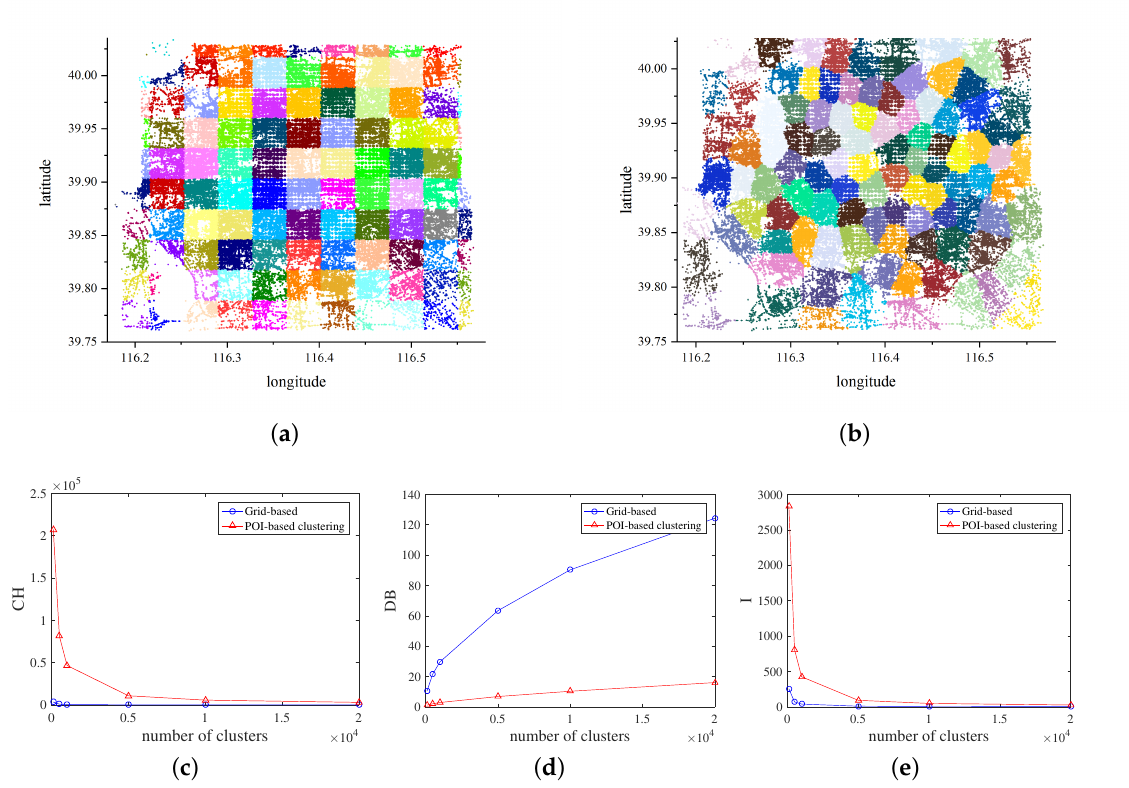
Figure 4. The comparison of the points of interest (POI)-based clustering and regular geographic grid. ( a ) The sample data is divided into 100 clusters using the method using regular geographic grid. The horizontal axis represents longitude and the ordinate axis represents latitude. Different colors in the figure represent different clusters. ( b ) The sample data are divided into 100 clusters using the POI-based clustering method. ( c ) The Calinski–Harabasz index at different clusters. ( d ) The Davies–Bouldin index at different clusters. ( e ) The I index at different